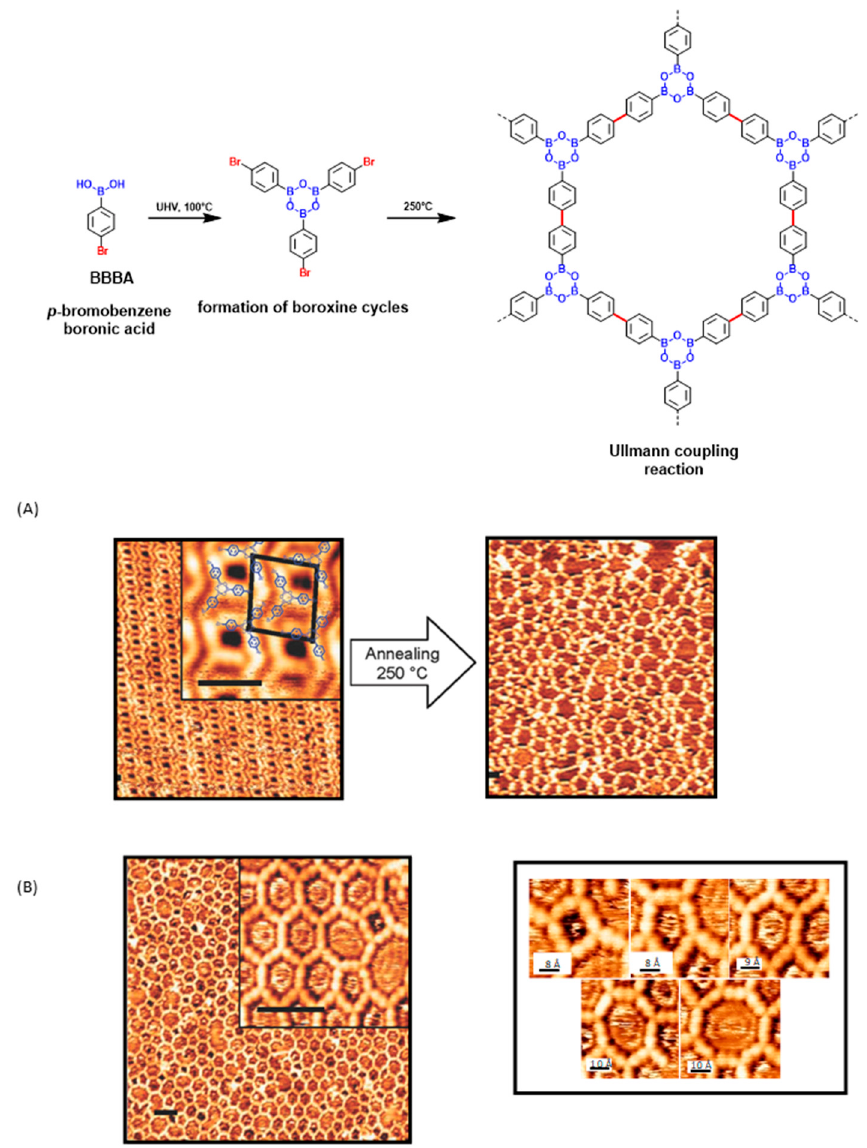
Figure 12. Polymerization reaction of p -bromobenzeneboronic acid (BBBA) on Au(111) substrates. ( A ) STM topographs of the supramolecular phase further annealed at 250 °C (10 nm × 14 nm, inset: scale bar = 2 nm). ( B ) STM topograph of the polymerization of BBBA in one step. Polygons of different shapes found on the Au(111) surface (left : scale bar = 4 nm). Adapted with permission from [95]. Copyright 2012 American Chemical Society.